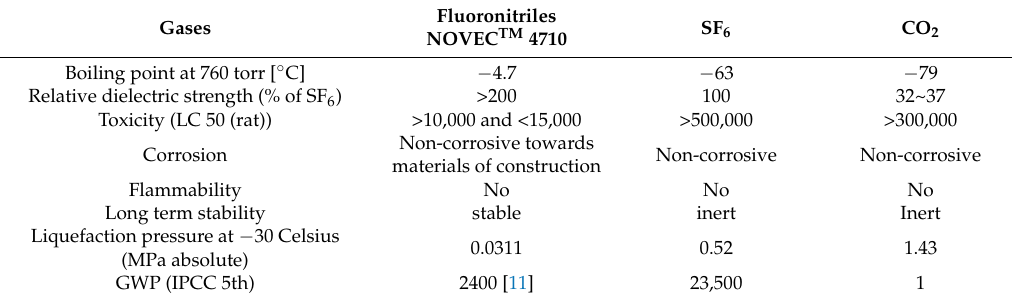
Table 15. Fundamental physical and chemical characteristics of some gases [9].